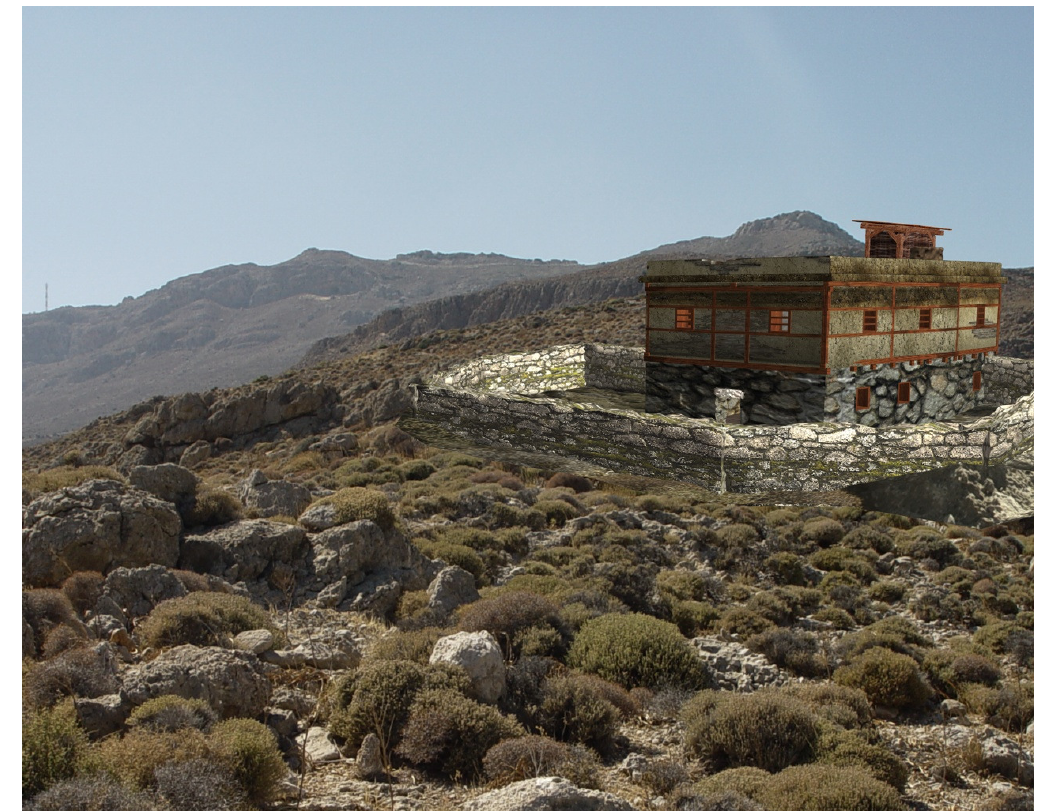
Figure 8. 3D reconstruction of Building I set into the real photo, view from the